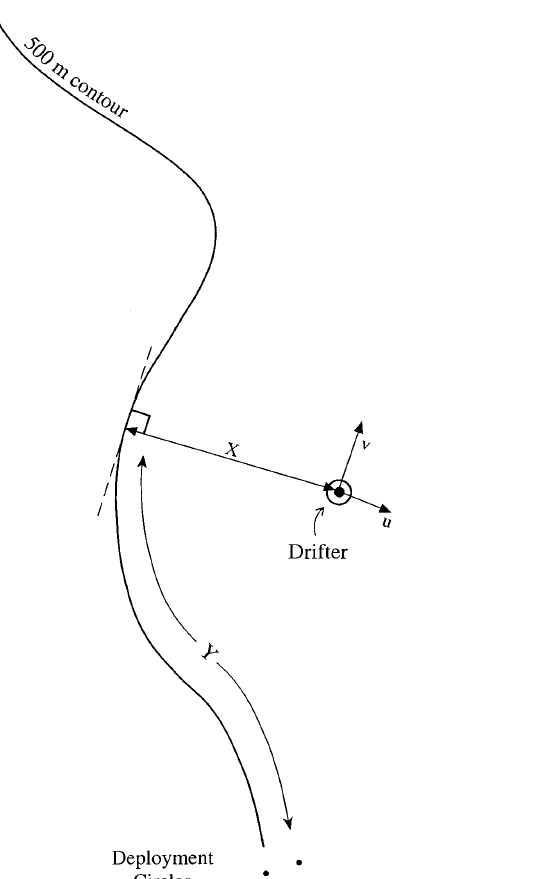
Fig. 2. Sketch of the across-slope, X , and along-slope, Y , positions and across-slope, u , and along-slope, v , speed components of drifters relative to the 500 m isobath and the release site. The coordinate X is measured normal to the nearest 500 m